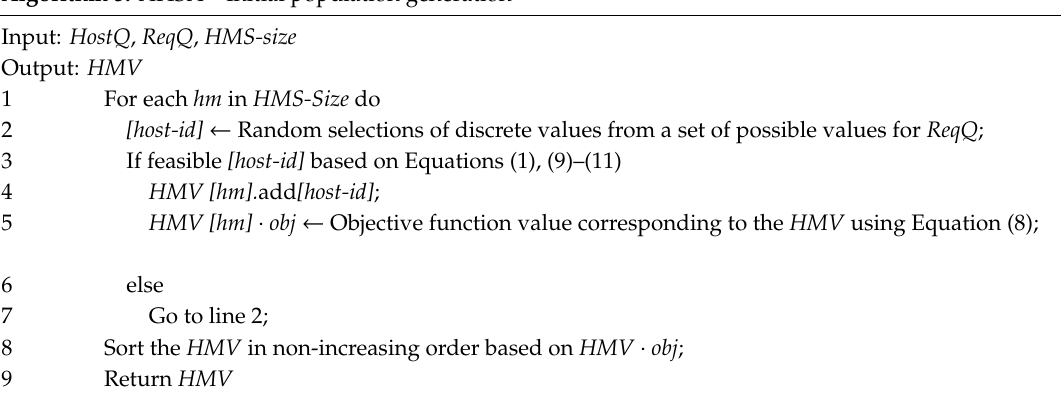
Algorithm 5: AHSA—Initial population